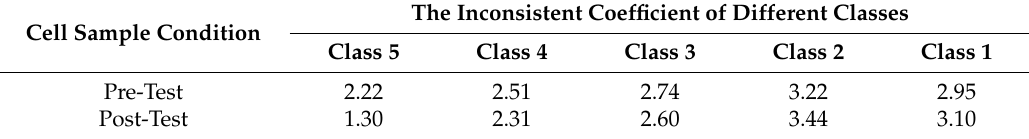
Table 6. The inconsistent coefficient of class merging before and after the vibration test.